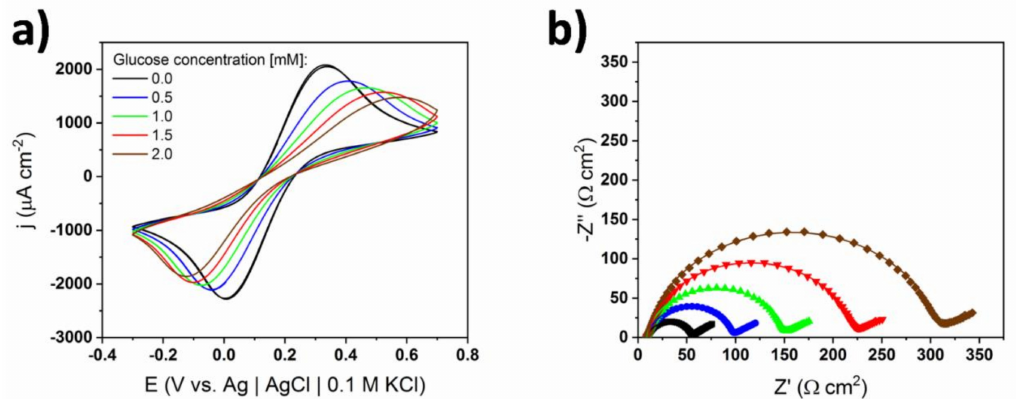
Figure 7. ( a ) Cyclic voltammograms, and ( b ) EIS spectra of bare TiND | AuNP electrode registered for di ff erent concentrations of glucose in 0.1 M sPBS containing 10 mM of ferrocyanide redox pair. Dotted lines correspond to measured impedance data and continuous lines to fitted